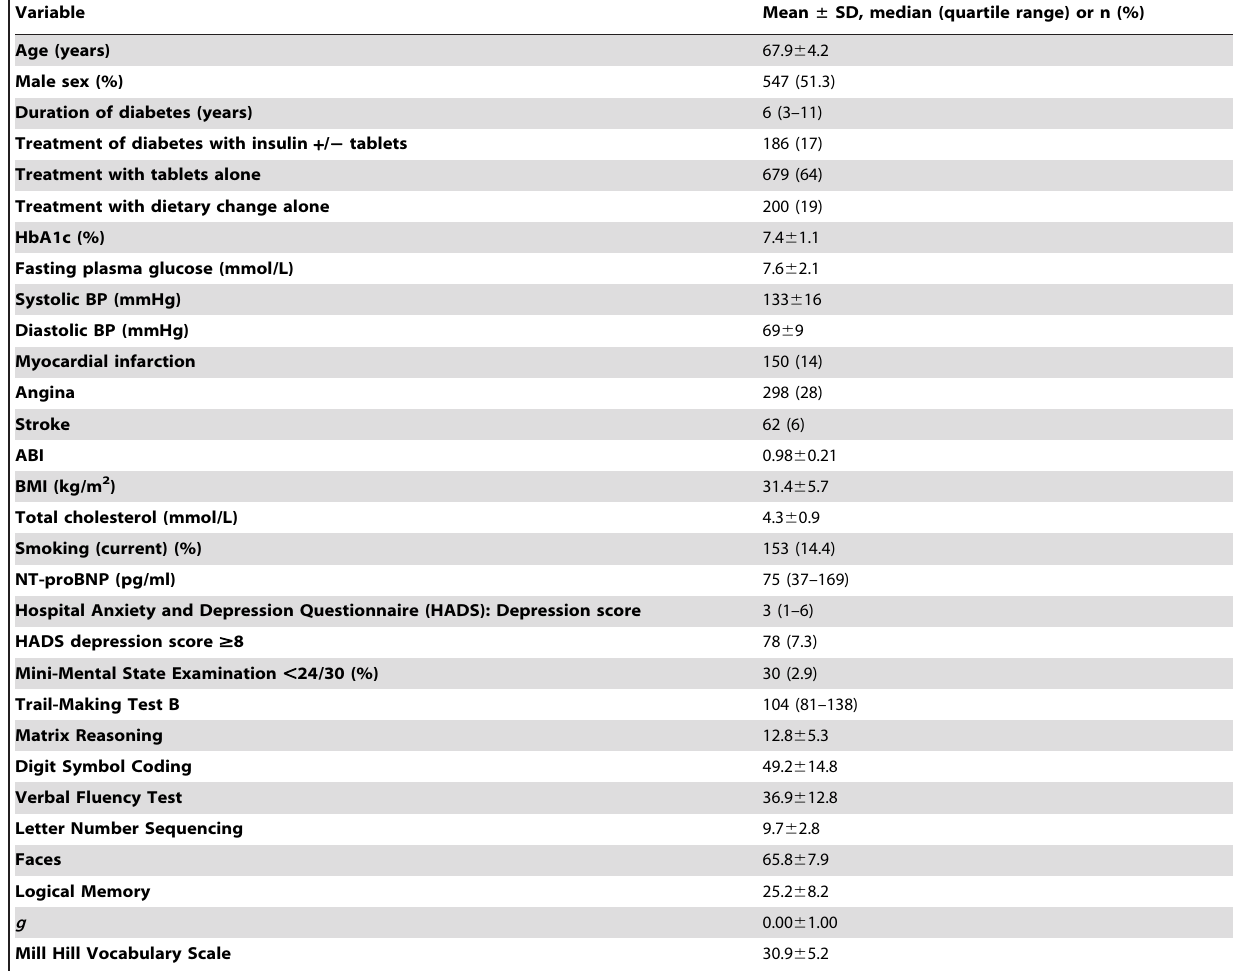
Table 1. Baseline characteristics of the ET2DS